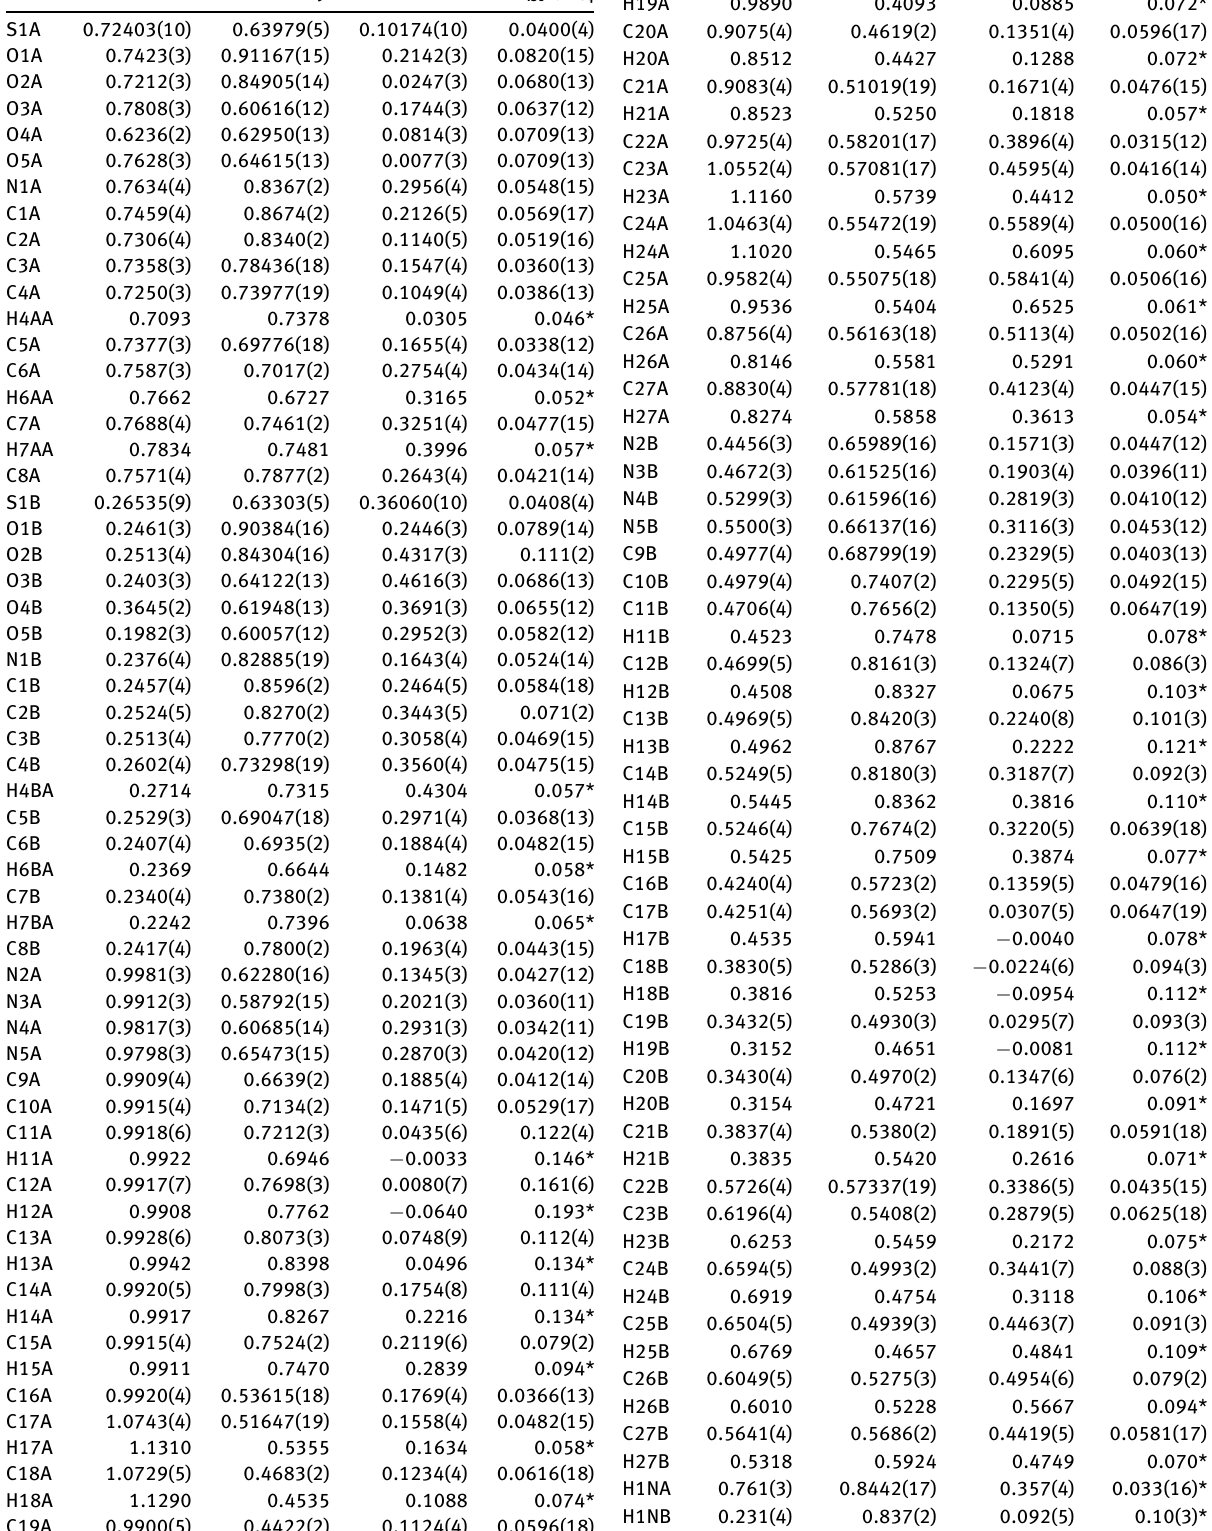
Table 2: Fractional atomic coordinates and isotropic or equivalent isotropic displacement parameters (Å 2